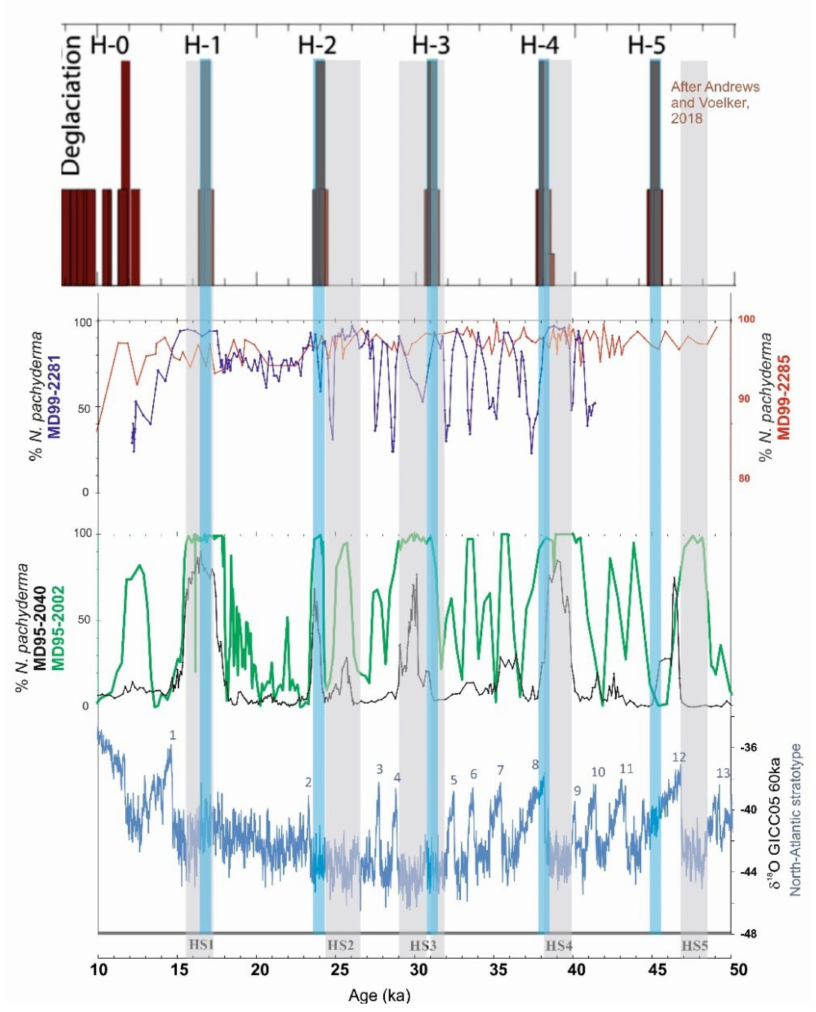
Figure 3. Graphic backbone of the stratigraphy between 50 and 10 ka BP using the North Atlantic stratotypical reference (i.e., NGRIP δ 18 O after [46], along which are numbered the Greenland intersta- dials) with vertical bars identifying the main cold events, i.e., Heinrich events (light blue bands) from Andrews and Voelker, 2018 [45] (we strictly respected the indications from the authors—”timing of the Hudson Strait Heinrich/detrital carbonate events—ages plotted with a range of ± 0.2 ky with the central bar two-times the height of the range”) and associated stadial intervals (Heinrich stadials (HS), grey bands) from Wolff et al., 2010, [47] and Wary et al., 2017 [43]. Along this framework, the abundance (% in the >150 µ m assemblages) of the cold polar taxa Neogloboquadrina pachyderma (NP) is reproduced, as originally published, in the four selected cores (see Table 1 for references). NP abundances are generally used to infer cold HEs positions in marine sedimentological archives and to tie those events between different archives (e.g., Waelbroeck et al., 2019 [48]). For color used in this figure, the reader is referred to the Web version of this